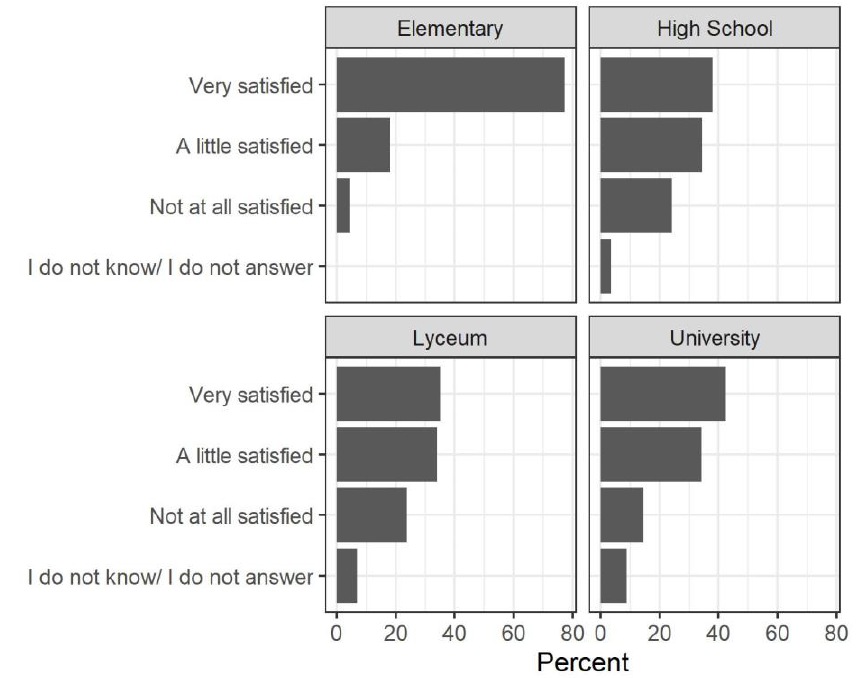
Figure A11. Cross-tabulation of attitudes of believers about the reopening of the Churches by education (% by education). Χ 2 = 18.121, df = NA, p = 0.030 (Pearson’s Chi-squared test with simulated p -value based on 2000 replicates).